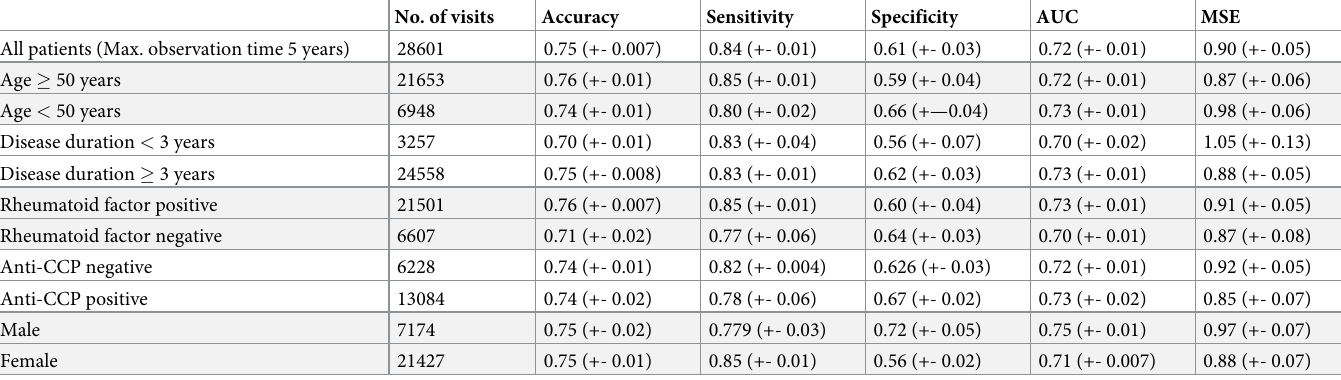
Table 2. Performance of an AdaptiveNet model for prediction of active disease in test sets containing different patient subsets. No. of visits Accuracy Sensitivity Specificity AUC